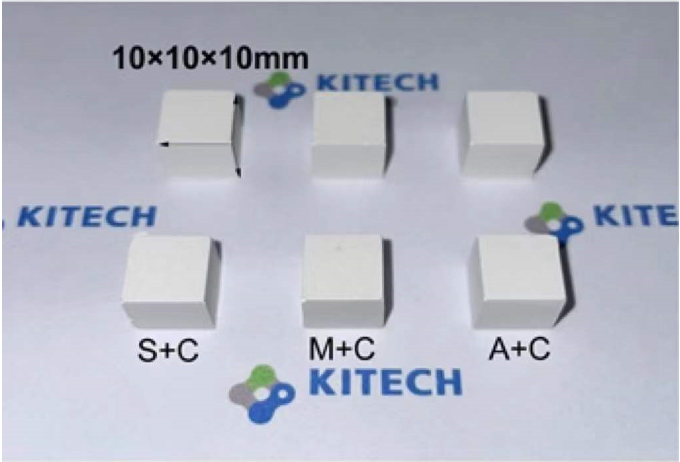
Figure 2. Cube molded bodies made from silicone